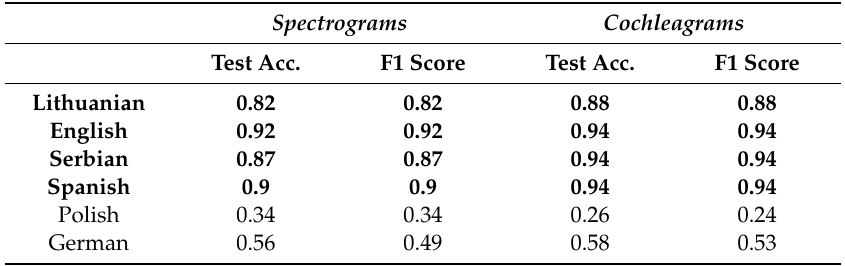
Table 6. Classification test results for spectrograms and cochleagrams: Lithuanian, English, Serbian, and Spanish datasets are used for training. The datasets that were used in the training process are highlighted in bold